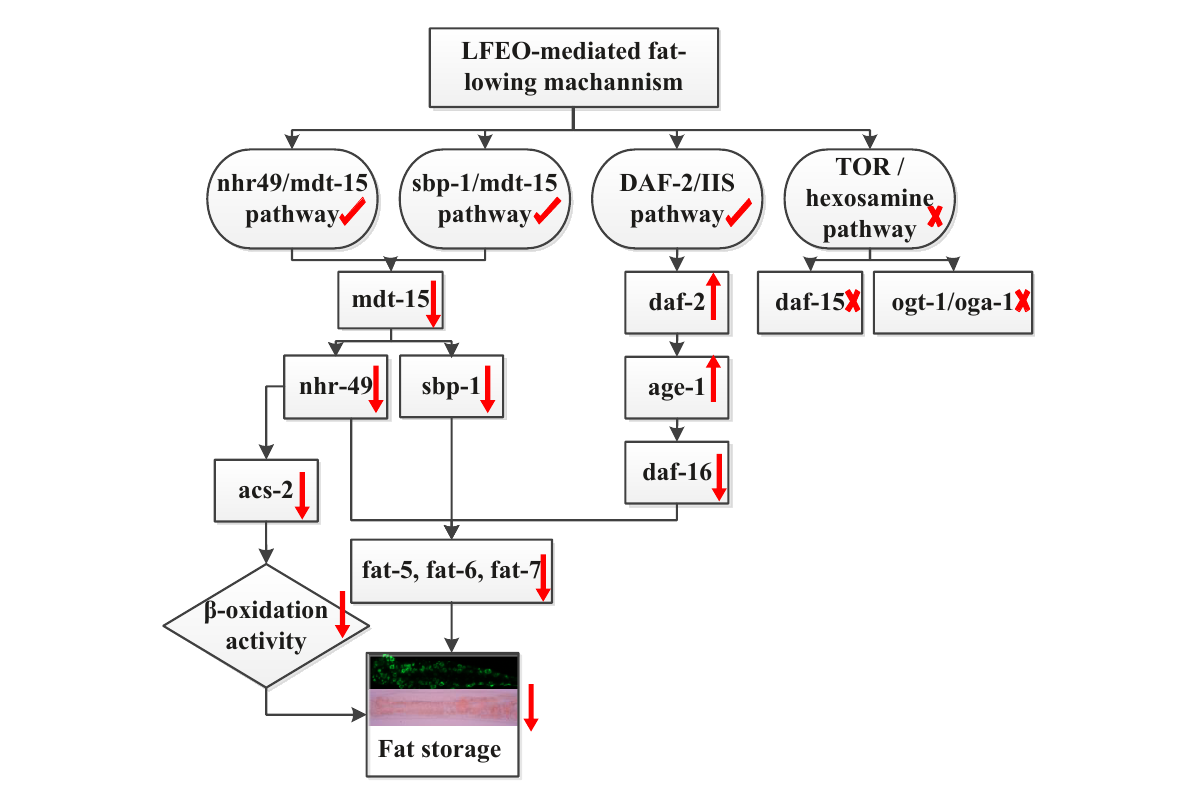
FIGURE8 The molecular mechanism of litchi flower essential oil (LFEO) mediated lipid-lowering effects.